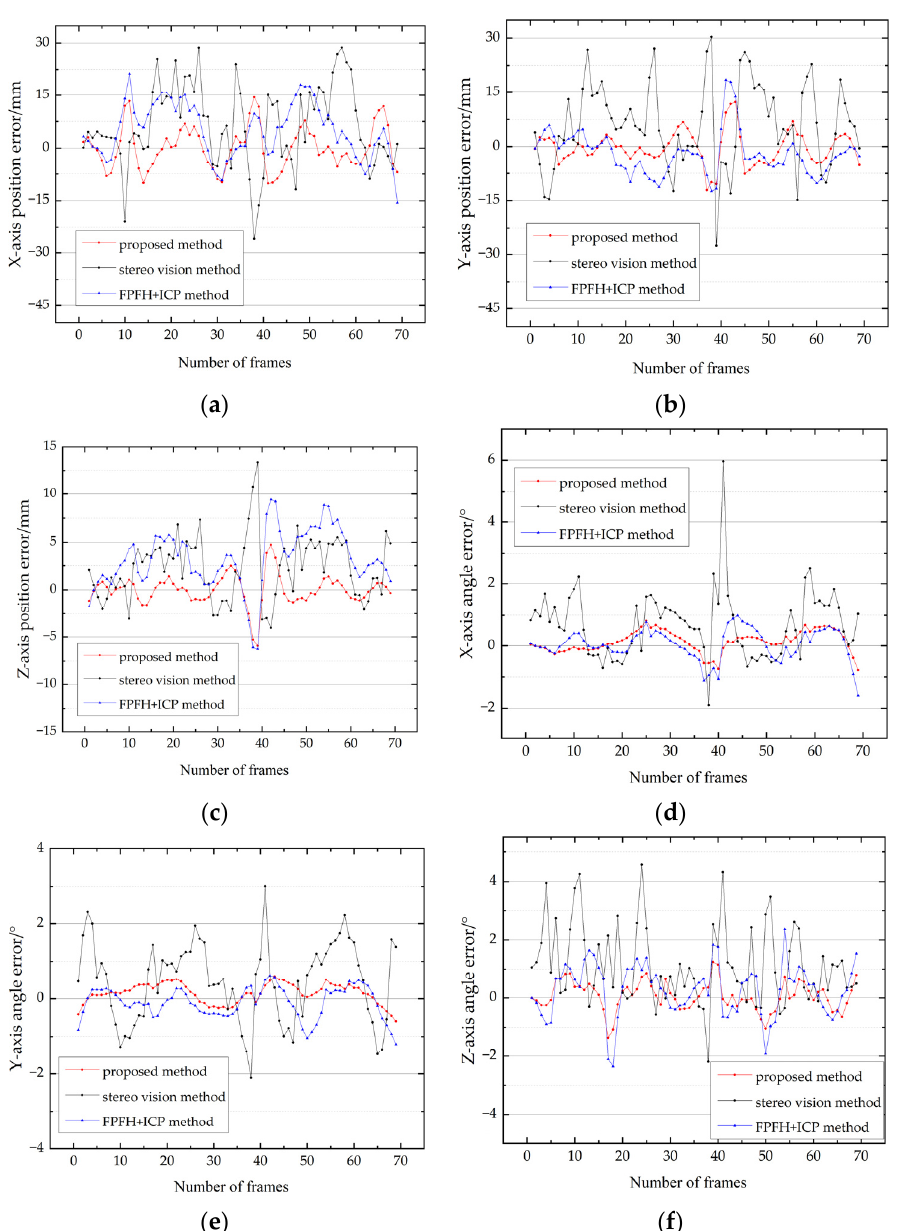
Figure 18. Comparison of the error results of the different methods at high speed: ( a ) X-axis position error; ( b ) Y-axis position error; ( c ) Z-axis position error; ( d ) X-axis angle error; ( e ) Y-axis angle error; ( f ) Z-axis angle error.